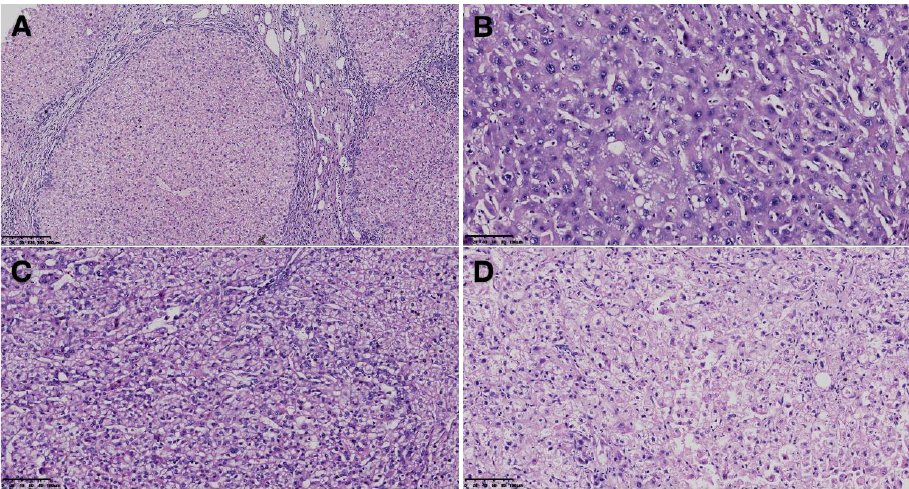
Figure 1. Histological characterization of hepatic cirrhosis ( A ), low-grade dysplastic nodule (LGDN) ( B ), high-grade dysplastic nodule (HGDN) ( C ), and early hepatocellular carcinoma (eHCC) ( D ). In cirrhosis, the normal lobular structure is destroyed and replaced by pseudolobules. The arrangement of hepatocytes in the pseudolobules is disturbed, accompanied by degeneration, necrosis, and regeneration of hepatocytes, and the central vein is often absent ( A ); LGDN is mainly characterized by macrocell dysplasia, with slightly increased density, portal structure, and no isolated arterioles of the pseudo glandular duct ( B ); HGDN is dominated by small cells with moderate to severe dysplasia, accompanied by structural dysplasia, and the cell arrangement density was significantly increased compared with the surrounding liver tissue ( C ); eHCC cell atypia is obvious, the cancer cells are different in size and shape, and the cancer cells are arranged in nests, with more of an interstitium ( D ). Note: Hematoxylin-esion staining, Magnification ×100 ( A ) and ×200 ( B – D ).